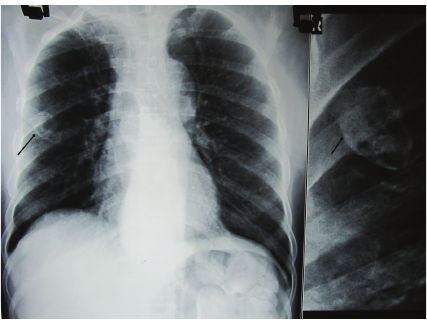
Figure 1: Arrowhead showing an expansile lesion involving right 4th rib.